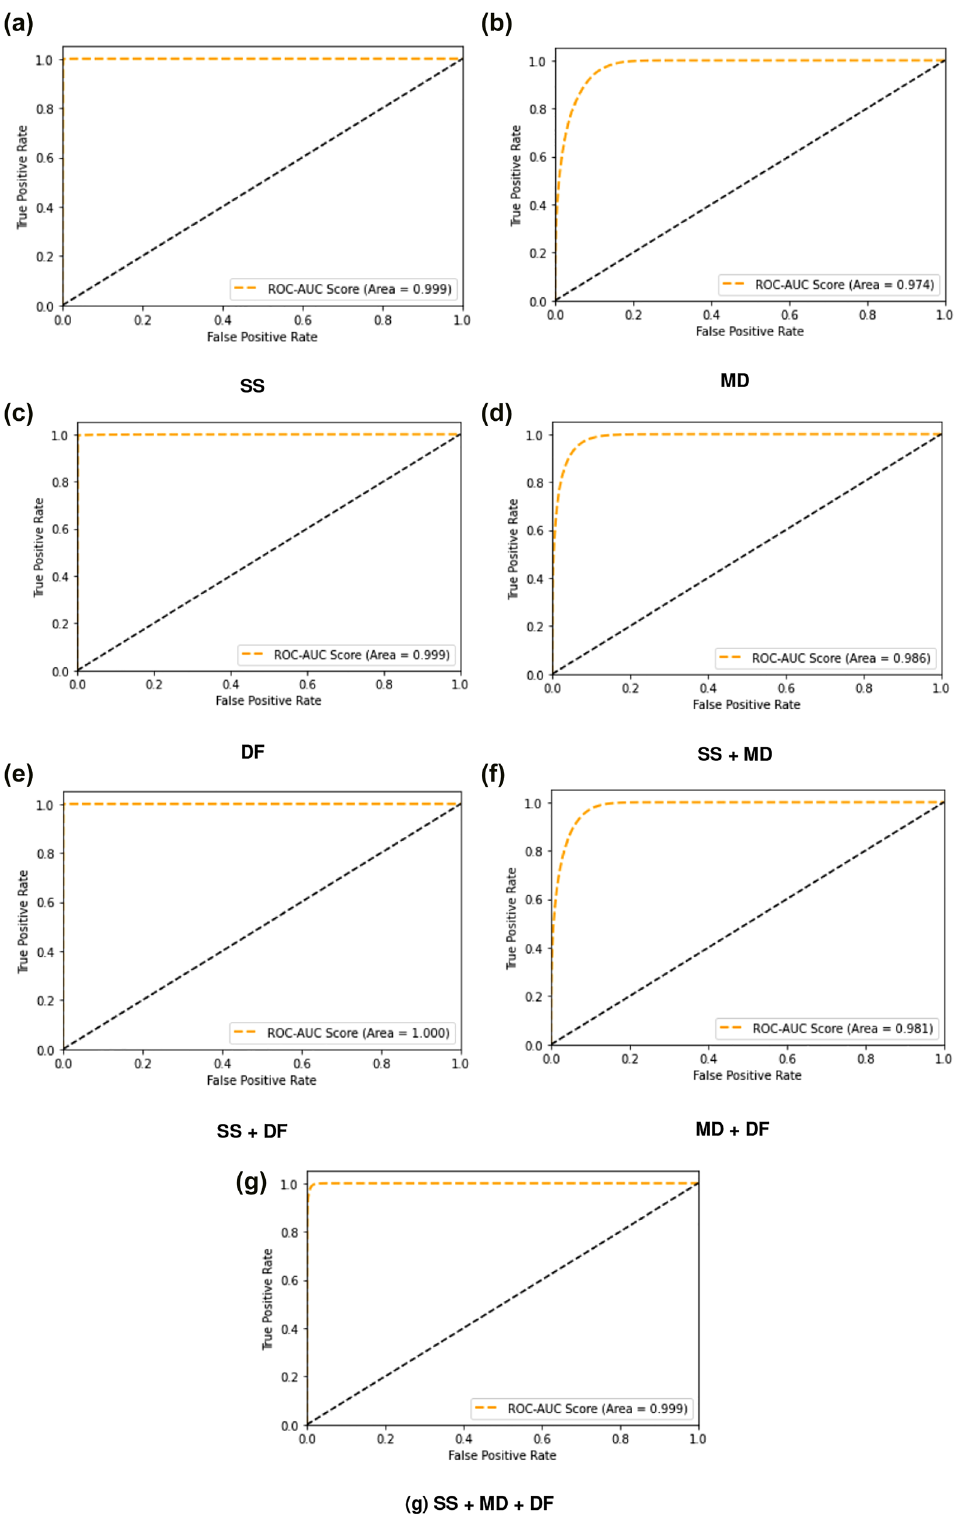
Figure 4: ROC-AUC for different